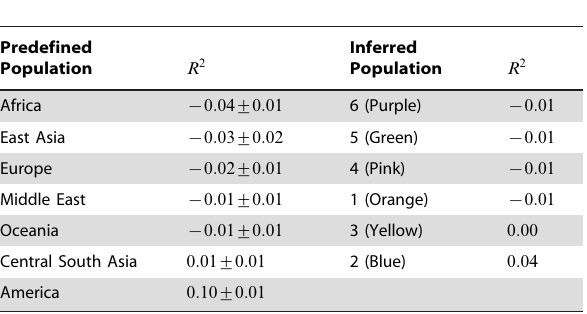
Table 2. Changes from the observed R 2 value when each continent and inferred population is removed in turn for the human